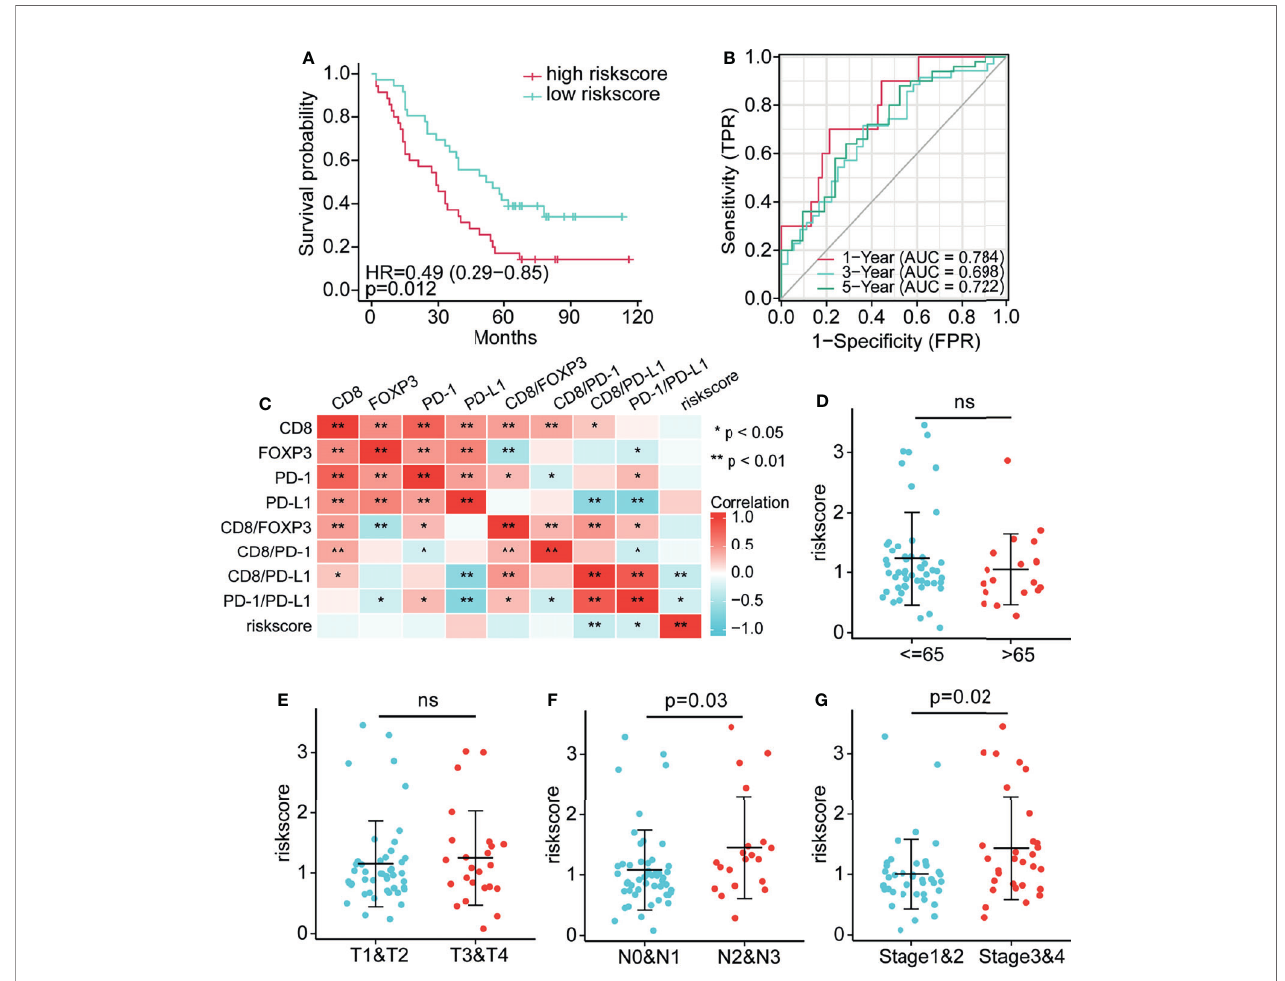
FIGURE 7 | Establishment of the risk score and assessment of its prognostic signi fi cance (A) Compared with the high risk score group, the low risk score group had signi fi cantly better survival. (B) AUC values for 7-factor predictions models. (C) Heatmap comparing immune cell abundance with the risk score. (D – G) The association between clinical information, (D) age, (E) tumor, (F) lymph node, and (G) AJCC stage and the risk score. * p < 0.05, ** p < 0.01, ns p >